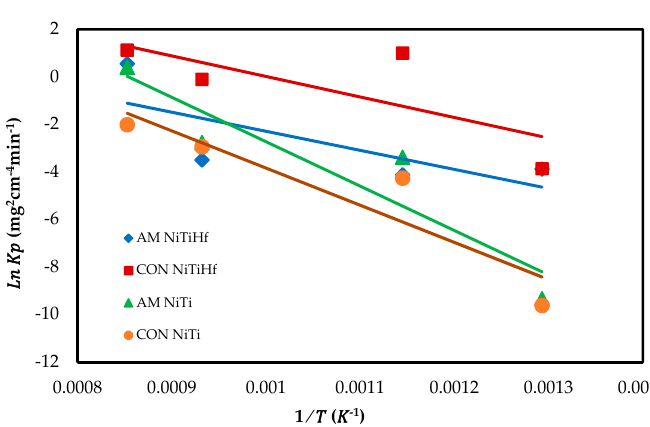
Figure 4. Arrhenius plot of the parabolic rate constant of AM NiTiHf, CON NiTiHf, and AM NiTi alloys.